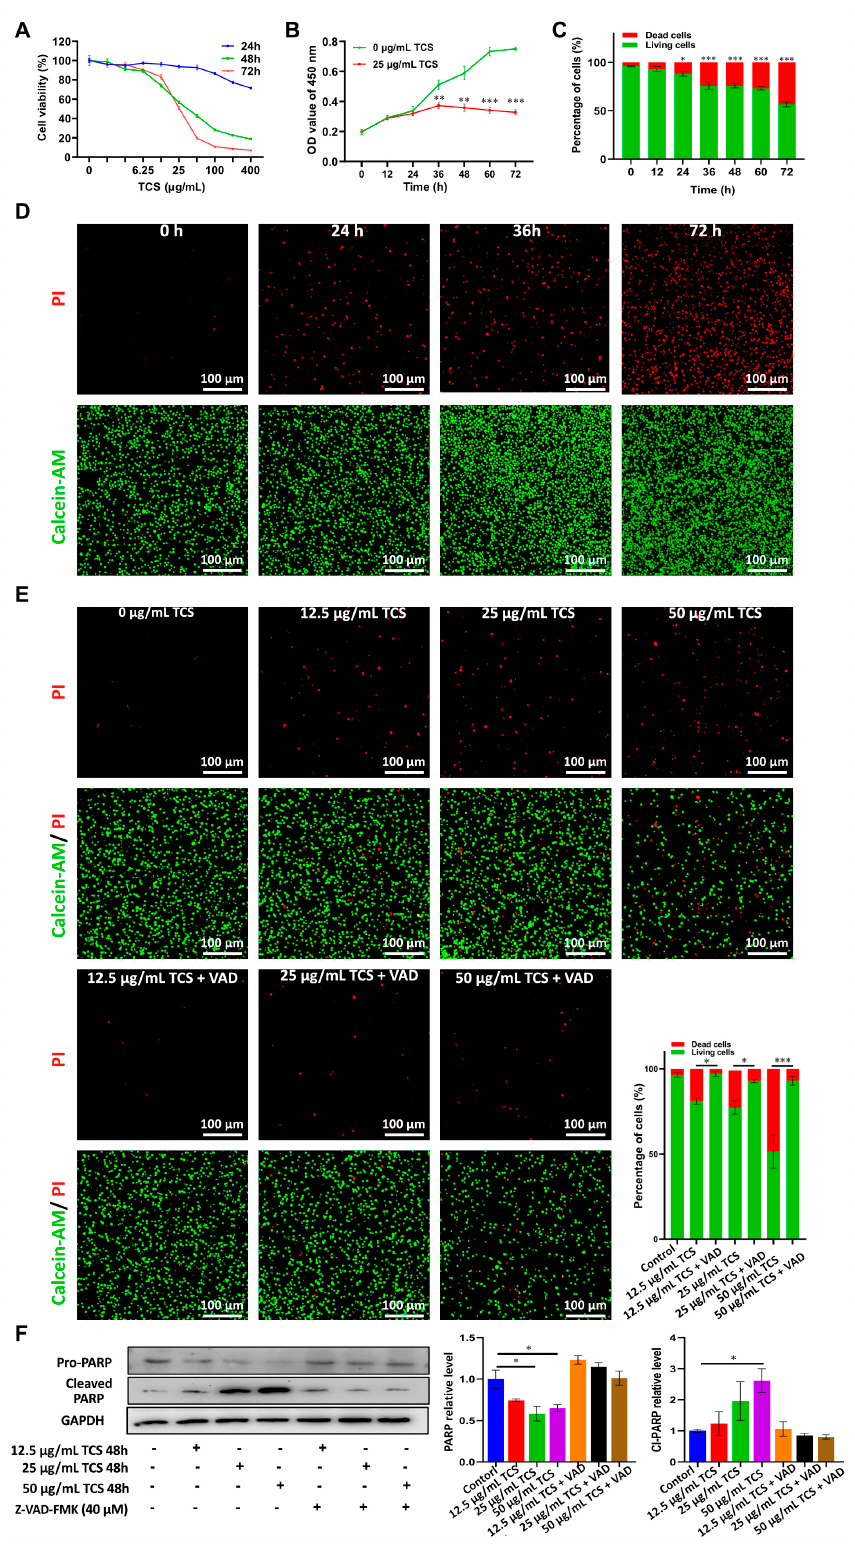
Figure 1. Effects of TCS on the cell viability and death of HCC cells. ( A ) H22 HCC cells were treated with different doses of TCS for 24 h, 48 h and 72 h. CCK-8 assay with absorbance at 450 nm was used to evaluate the cell viability; ( B ) IC50 dose of TCS (25 μ g/mL) was used to treat H22 HCC cells